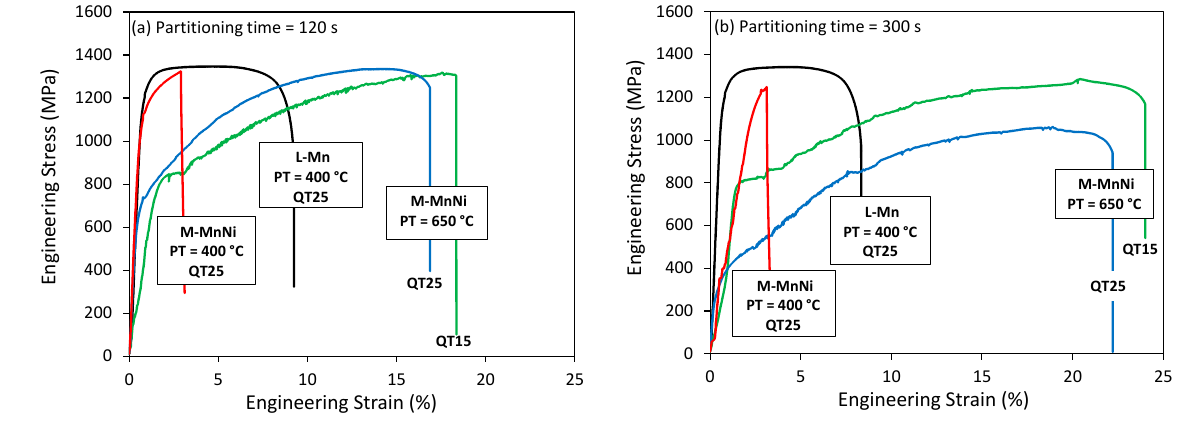
Figure 9. Engineering stress–strain curves obtained after Q&P treatments for L-Mn steel (QT25/PT = 400 °C) and for M-MnNi steel (QT25/PT = 400 °C, QT25/PT = 650 °C and QT15/PT = 650 °C): ( a ) partitioning time = 120 s; ( b ) partitioning time = 300 s. Tests performed using standard 50 mm gauge length samples. Table 3. Summary of tensile (yield strength (YS), tensile strength (TS) and total elongation (TEL)), bending and hole expansion (hole expansion ratio (HER)) properties for L-Mn and M-MnNi steels after Q&P treatments.